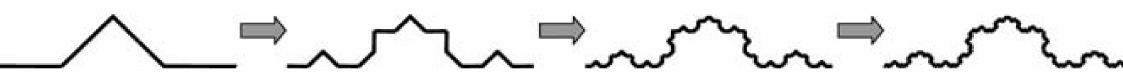
Figure 5. Shape of second-order Koch fractals used as dipoles in PLPDA design in [36].